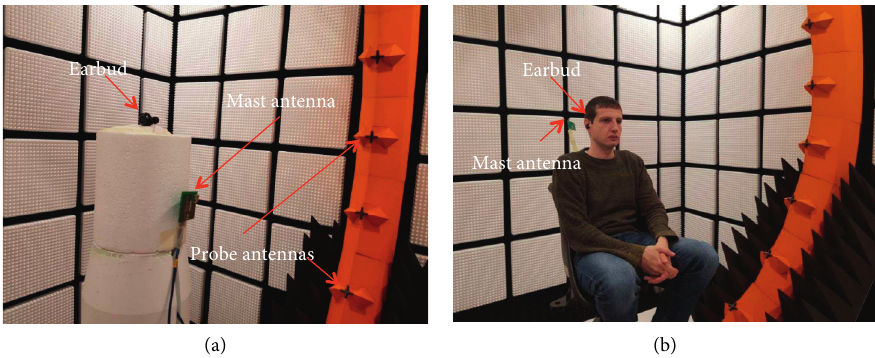
Figure 1: Setup for testing the transmit performance of the right-side earbud placed in (a) free space and (b) right ear of a